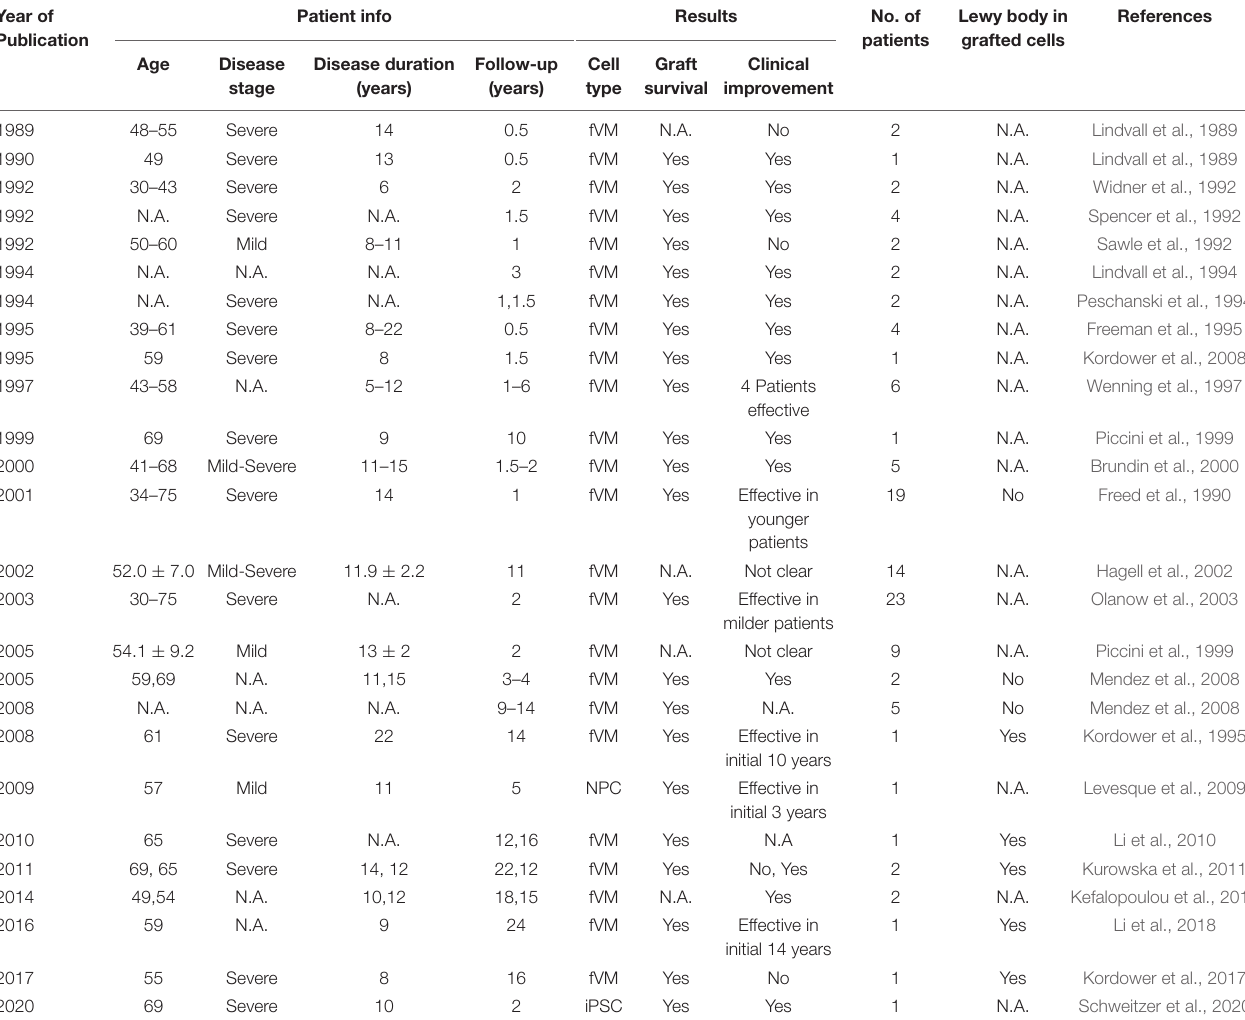
TABLE 3 | Summary of clinical studies in cell transplantation for